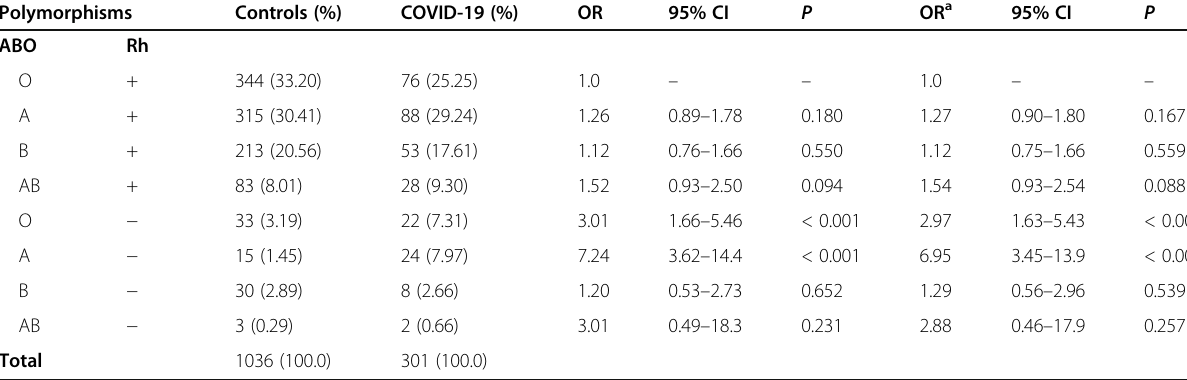
Table 2 Combination phenotypes of the ABO and Rh blood groups and susceptibility to COVID-19